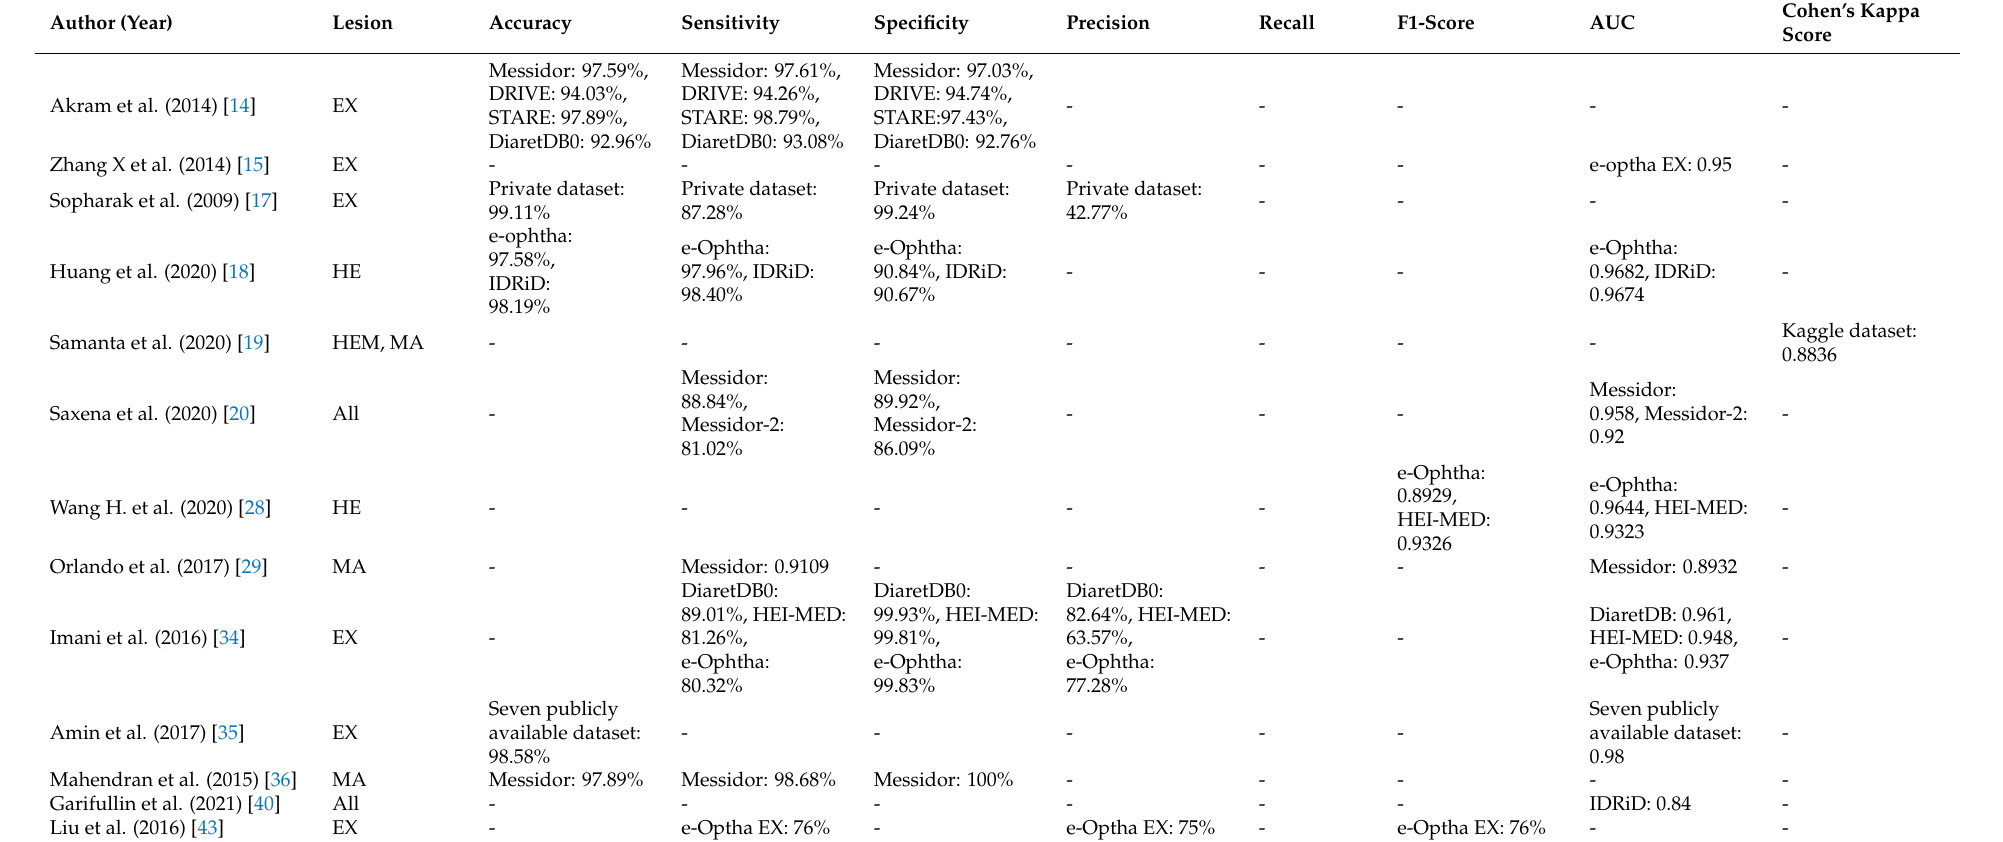
Table 12. Performance metrics achieved by various